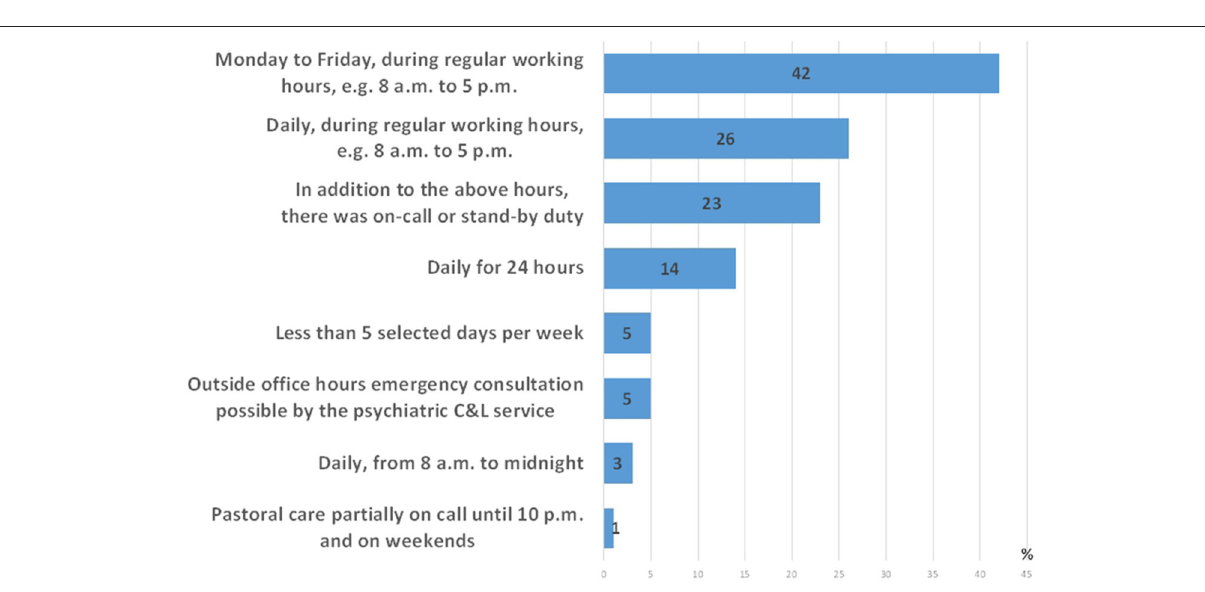
COVID-19, whereas 21 CL services (21%) provided no COVID- psyCare. The following information refers to those 77 CL services (43 from Germany, 16 from Austria, 18 from Switzerland) that offered